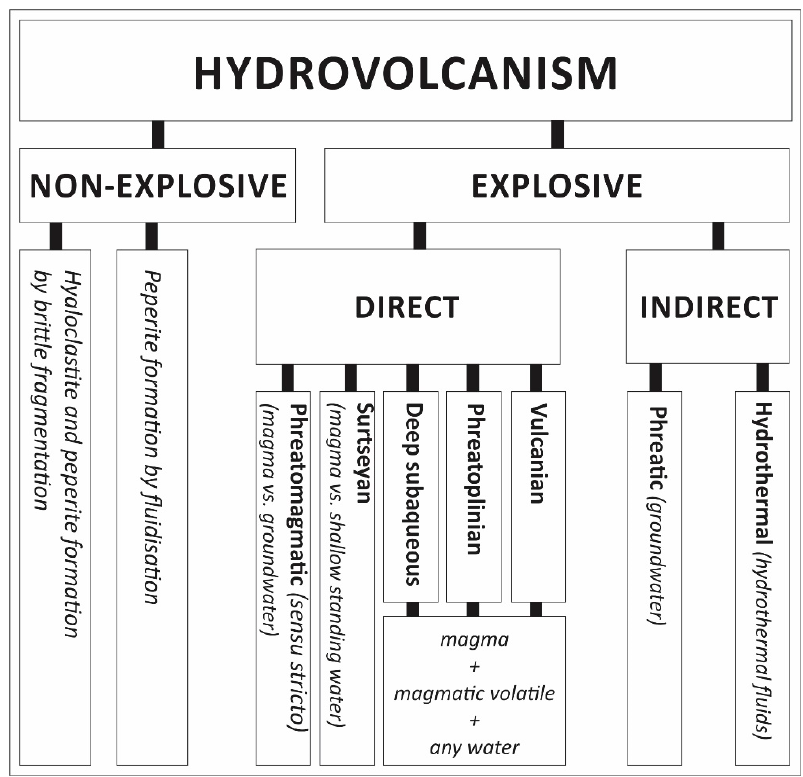
Figure 1. Proposed classification of hydrovolcanism using a process and products perspective. “Deep subaqueous” category contains a typical Surtla-type volcano, while the “Phreatomagmatic” category would be similar but broader to those defined by Taalian-type volcanism.